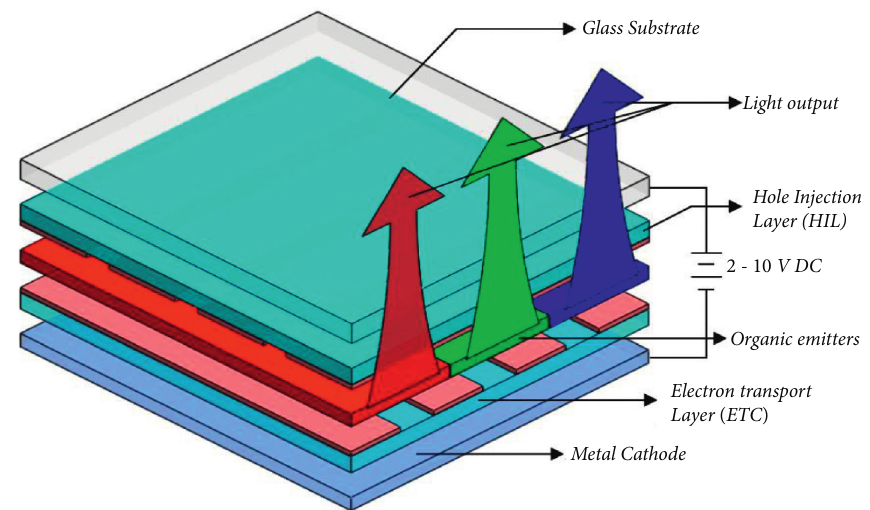
Figure 2: Typical construction of an